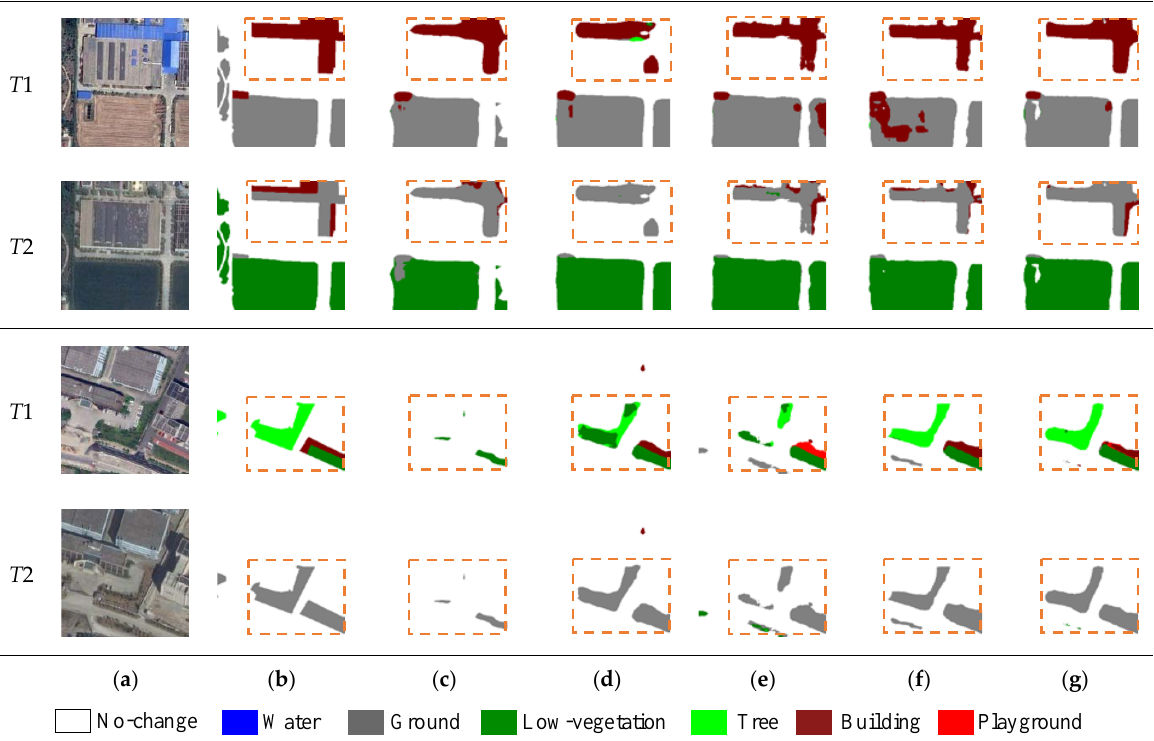
Figure 6. Comparisons of the change maps obtained by different methods on the SECOND dataset. ( a ) images, ( b ) GT, ( c ) FC-Siam-conc, ( d ) BiSRNet, ( e ) FCCDN, ( f ) BIT, and ( g ) SMNet (ours). We highlight interesting regions with orange boxes.